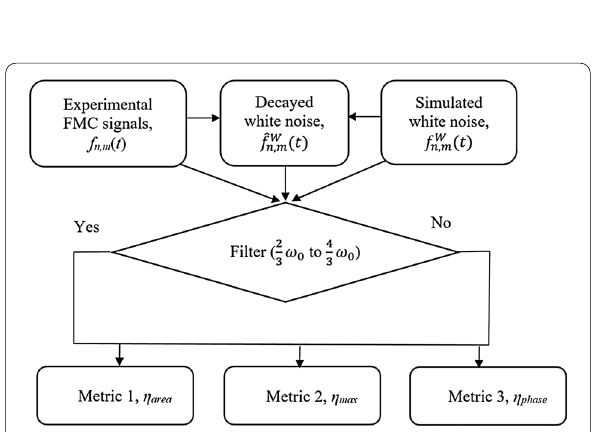
Figure 4 Flow chart of methodology for diffuse field verification